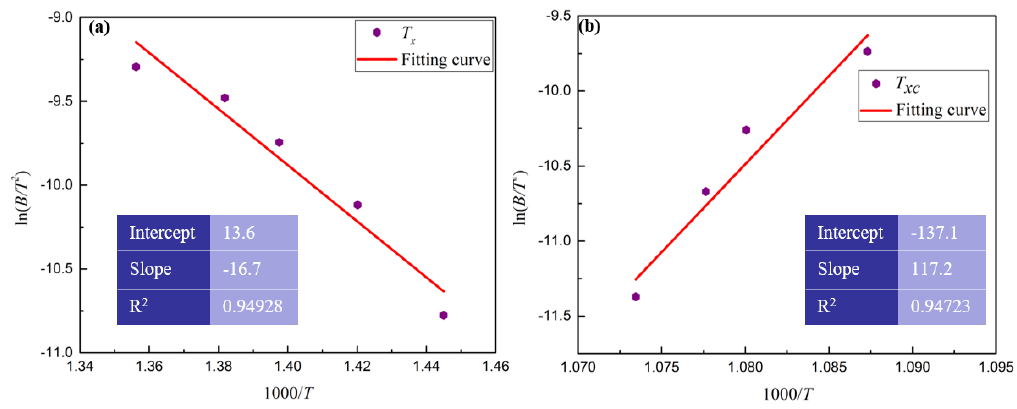
Figure 6. The linear fit between ln( B / T 2 ) and 1000 / T during ( a ) heating and ( b ) cooling process.